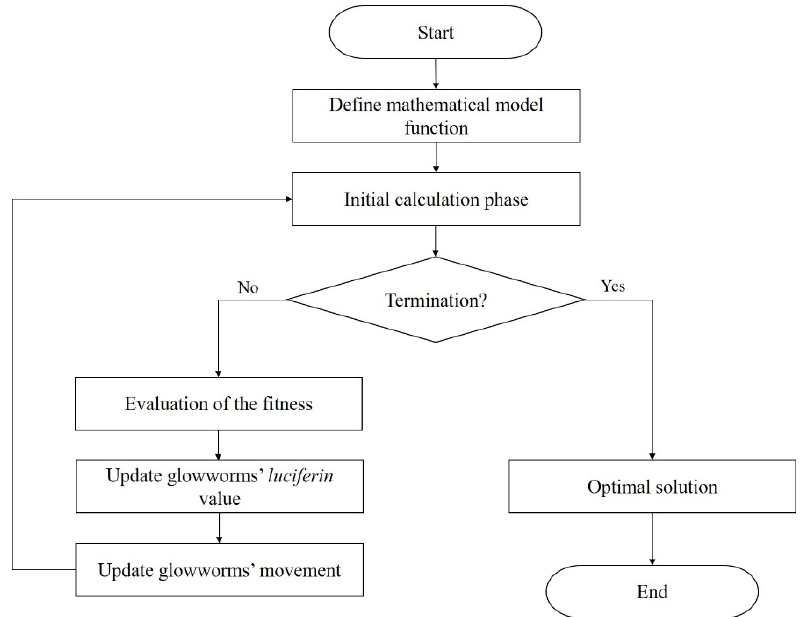
Figure 7 . Flowcharts of GA optimization process implemented by Hanid et al. [34], adapted from [34].